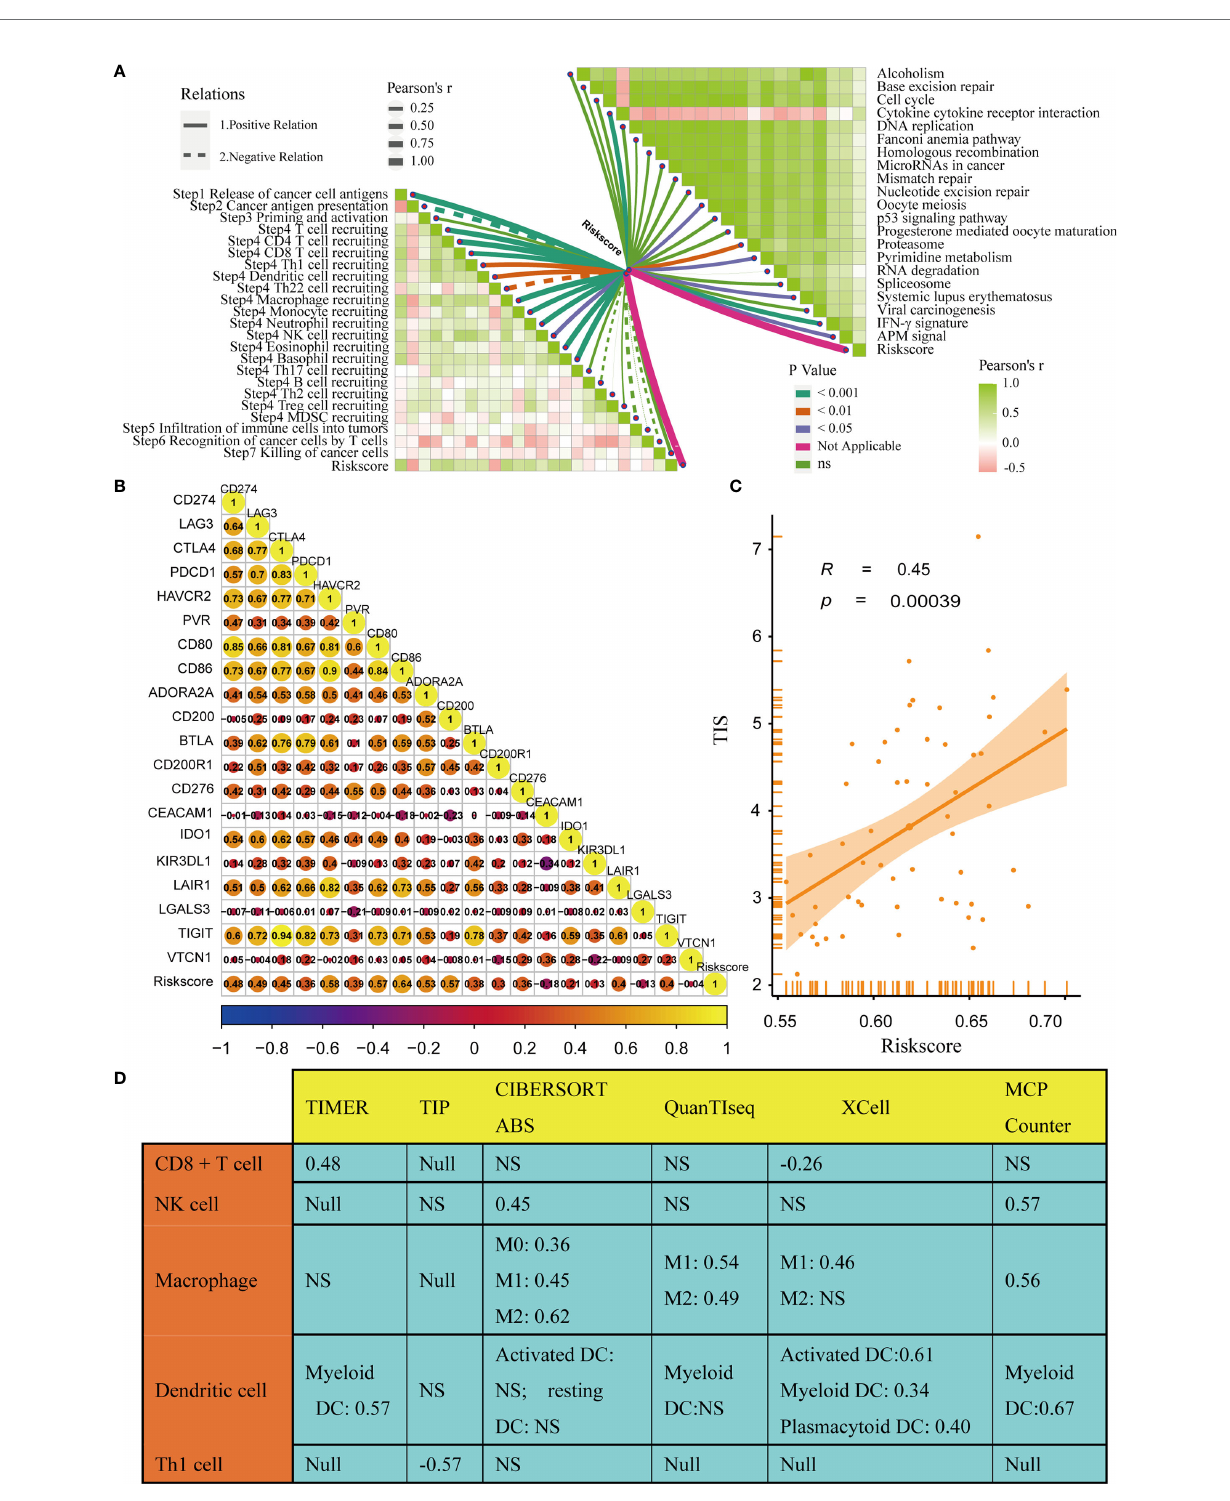
FIGURE 6 | Relationships between the TGF- b risk score and TME immune characters in the Xiangya Cohort. (A) Relationships between TGF- b risk score and activities of the cancer immunity cycles (left panel); Relationships between TGF- b risk score and the enrichment scores of ICB response related pathways (right panel). (B) Relationships between the risk score and several immune checkpoints. (C) Correlation between the risk score and the T cell in fl amed score (TIS). (D) Correlations between the risk score and the levels of several TIICs in six independent algorithms. NS, not signi fi